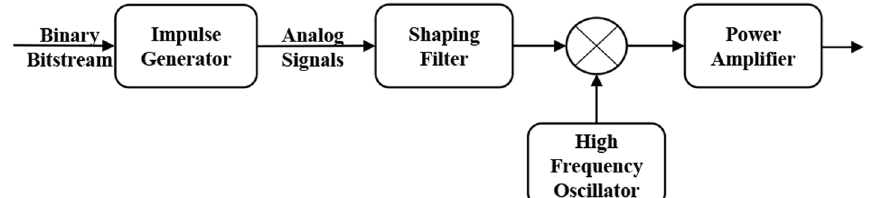
Fig. 1 Structure of an MASK communication